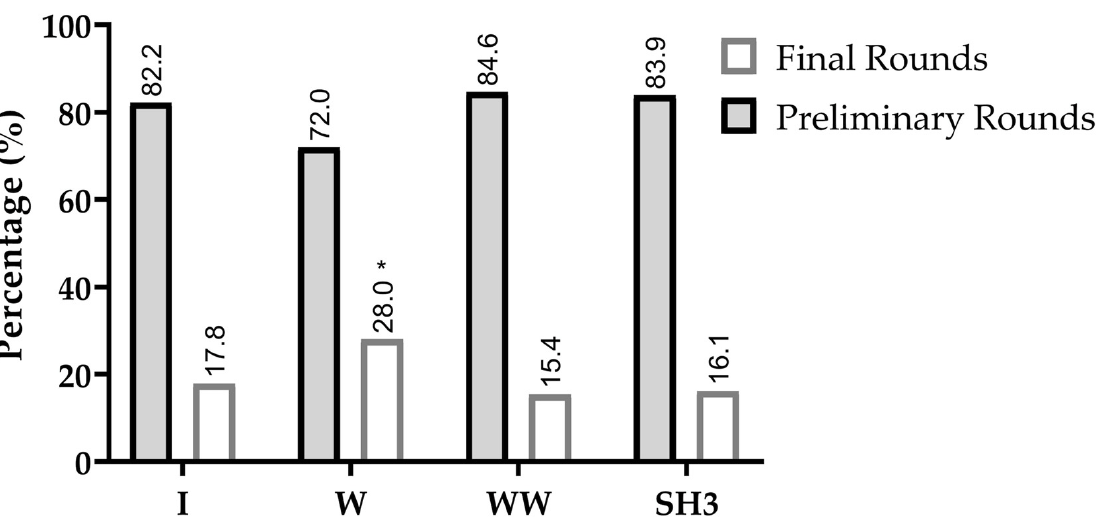
Figure 2. Relation between HwCE (I, WW, W and SH3) and grouped rounds (PR and FR) (n = 2340). * The variables leading to the most important contributions to difference, according to the to the SR; SRs = standardised residuals.